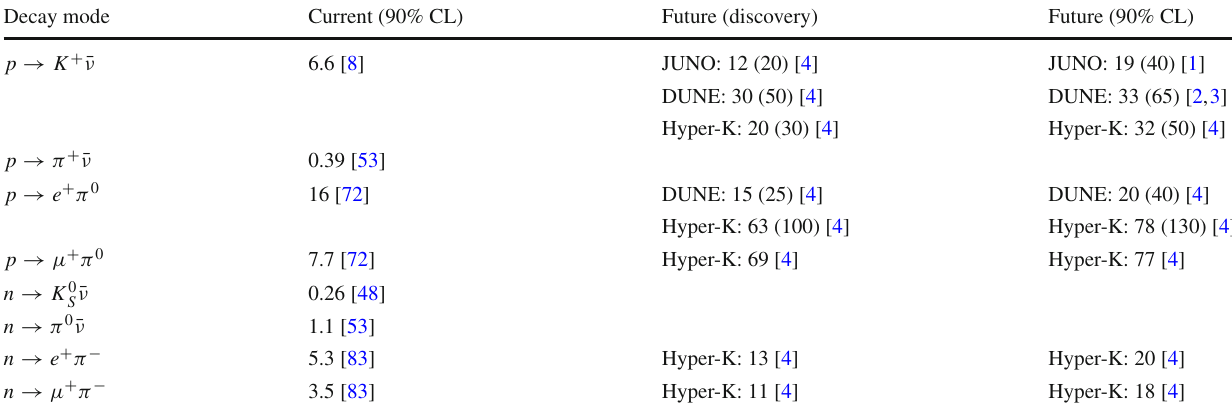
Table 1 Current baryon decay 90% CL limits and prospective future 90% CL limits and 3- σ discovery sensitivities in units of 10 33 years. For future prospects, we assume detector operations for 10 (20)